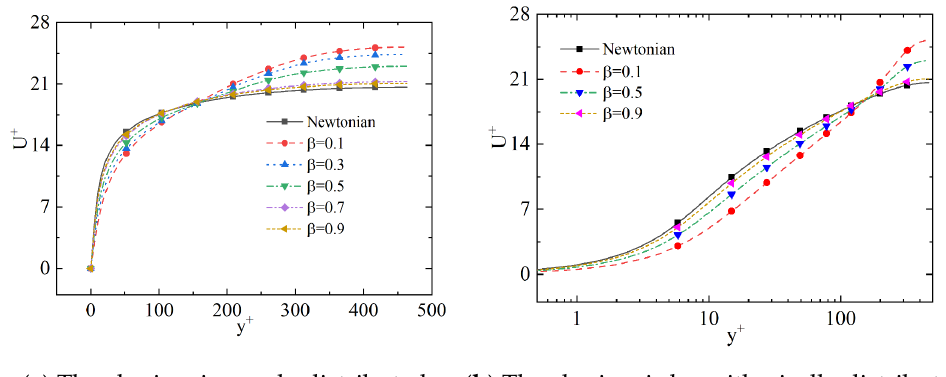
U  ) of different solvent viscosity ratios (  ).